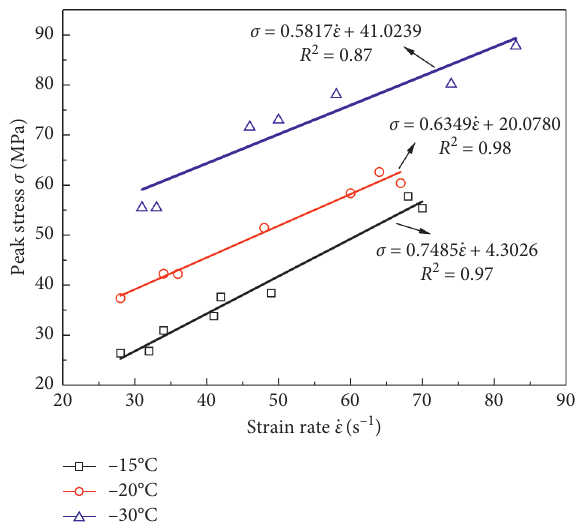
Figure 6: Relationship between the peak stress and the strain rate.